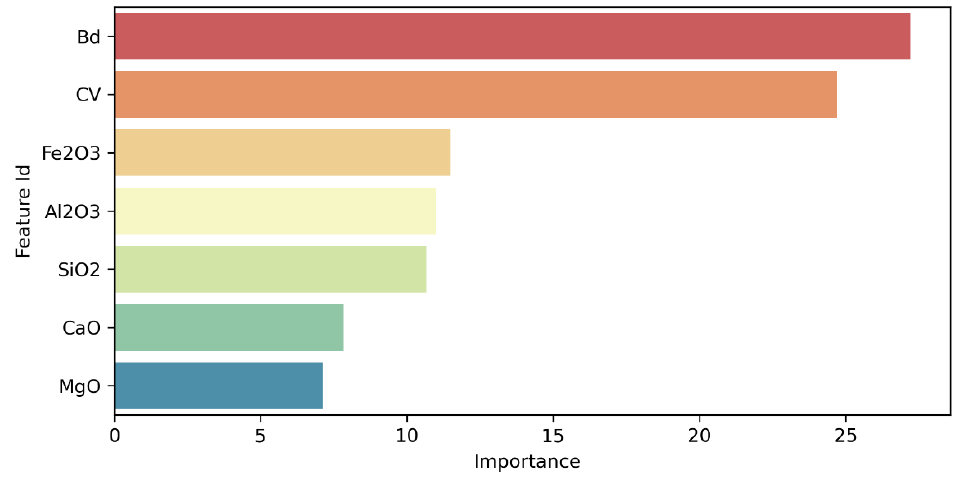
Figure 6. Features